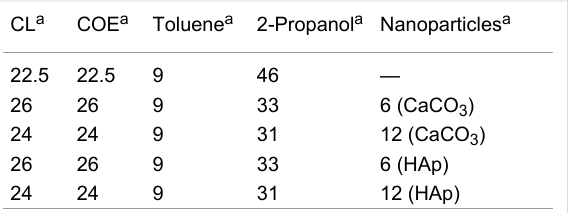
Table 1: Compositions of cis -5-cyclooctene- trans- 1,2-diol ( COE )- based